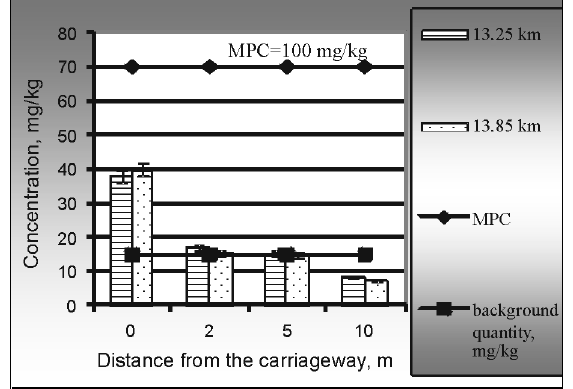
Fig. 5. Lead concentration in the roadside soil of the gravel road Jusevičiai – Būdvietis – Derviniai